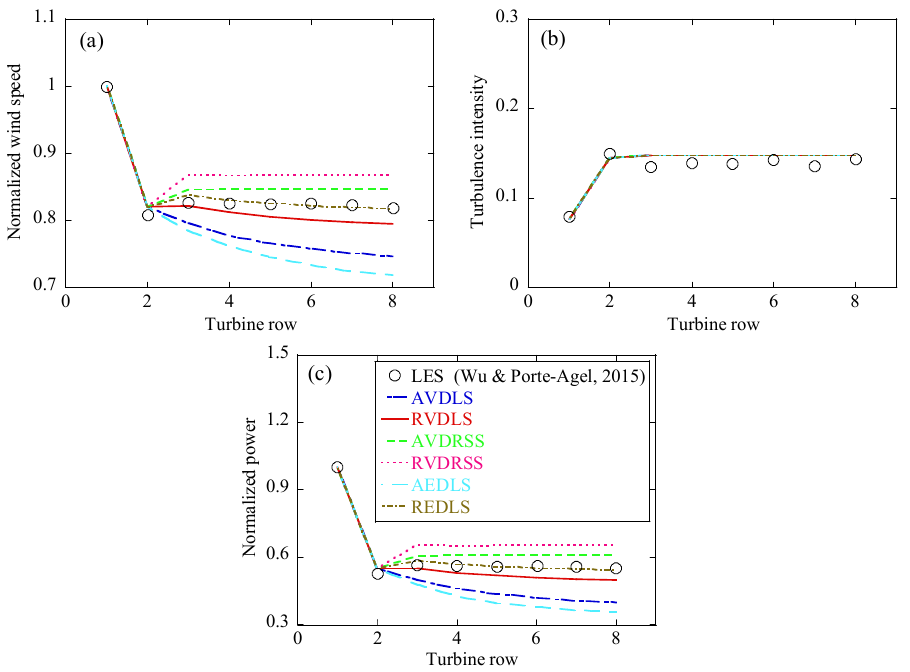
Figure 9. Comparisons of: ( a ) velocity deficit; ( b ) turbulence intensity; ( c ) power generations between simulations and predictions by the No. 29 combined wake model with different superposition approaches.